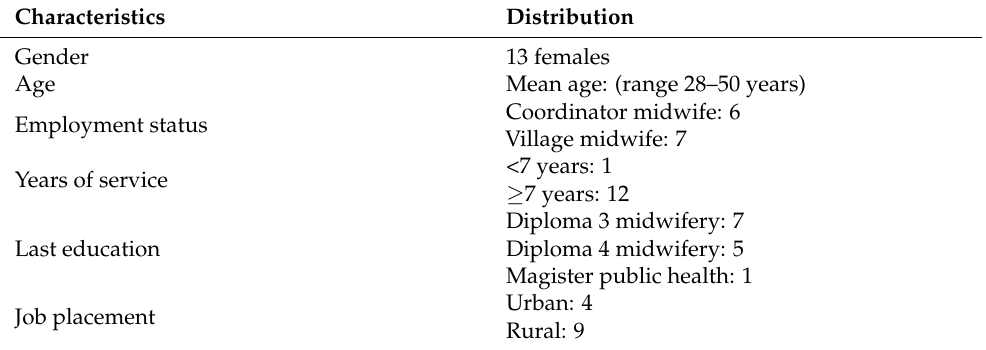
Table 4. Sociodemographic data of the participants of the qualitative